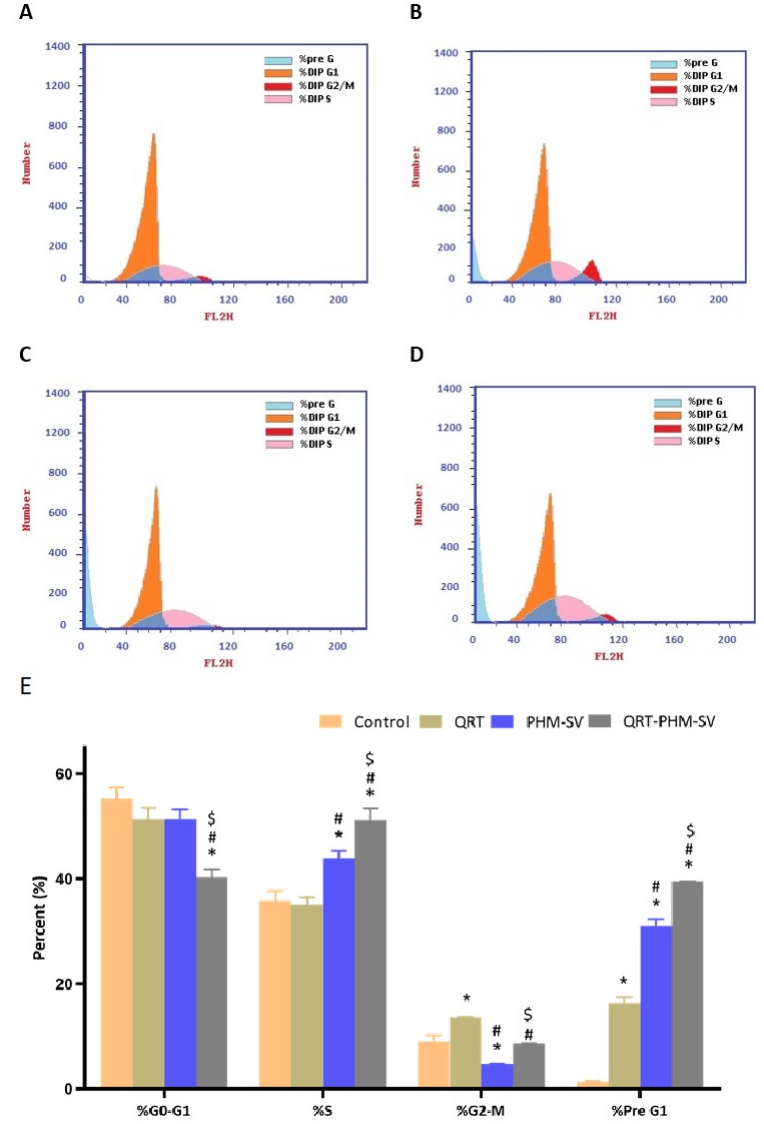
Figure 7. Flow cytometric analysis of control ( A ); QRT ( B ); PHM-SV ( C ); and QRT-PHM-SV-treated cells ( D ); and the percentages of cells in the G1, S, and G2/M phases of the cell cycle ( E ). * Significantly different from control at p < 0.05; # significantly different from QRT at p < 0.05.; $ significantly different from PHM-SVat p < 0.05.